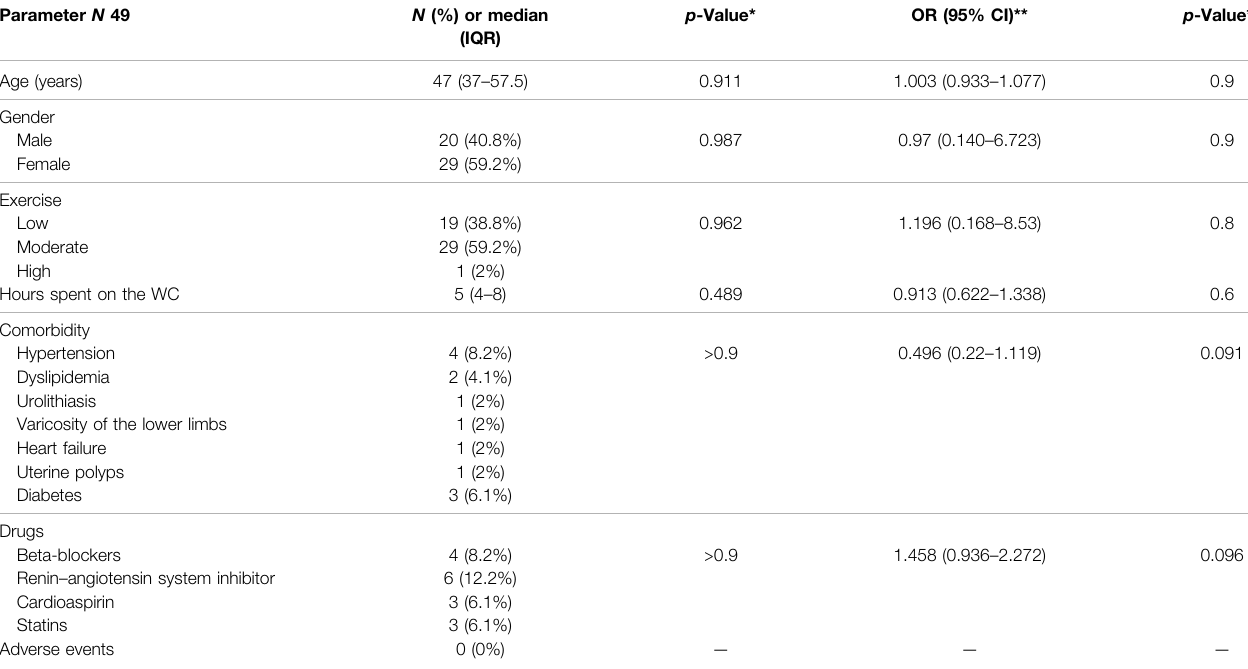
TABLE 3 | Demographic variable frequencies, expressed as numerosity (percentage of total) or median (interquartile range).